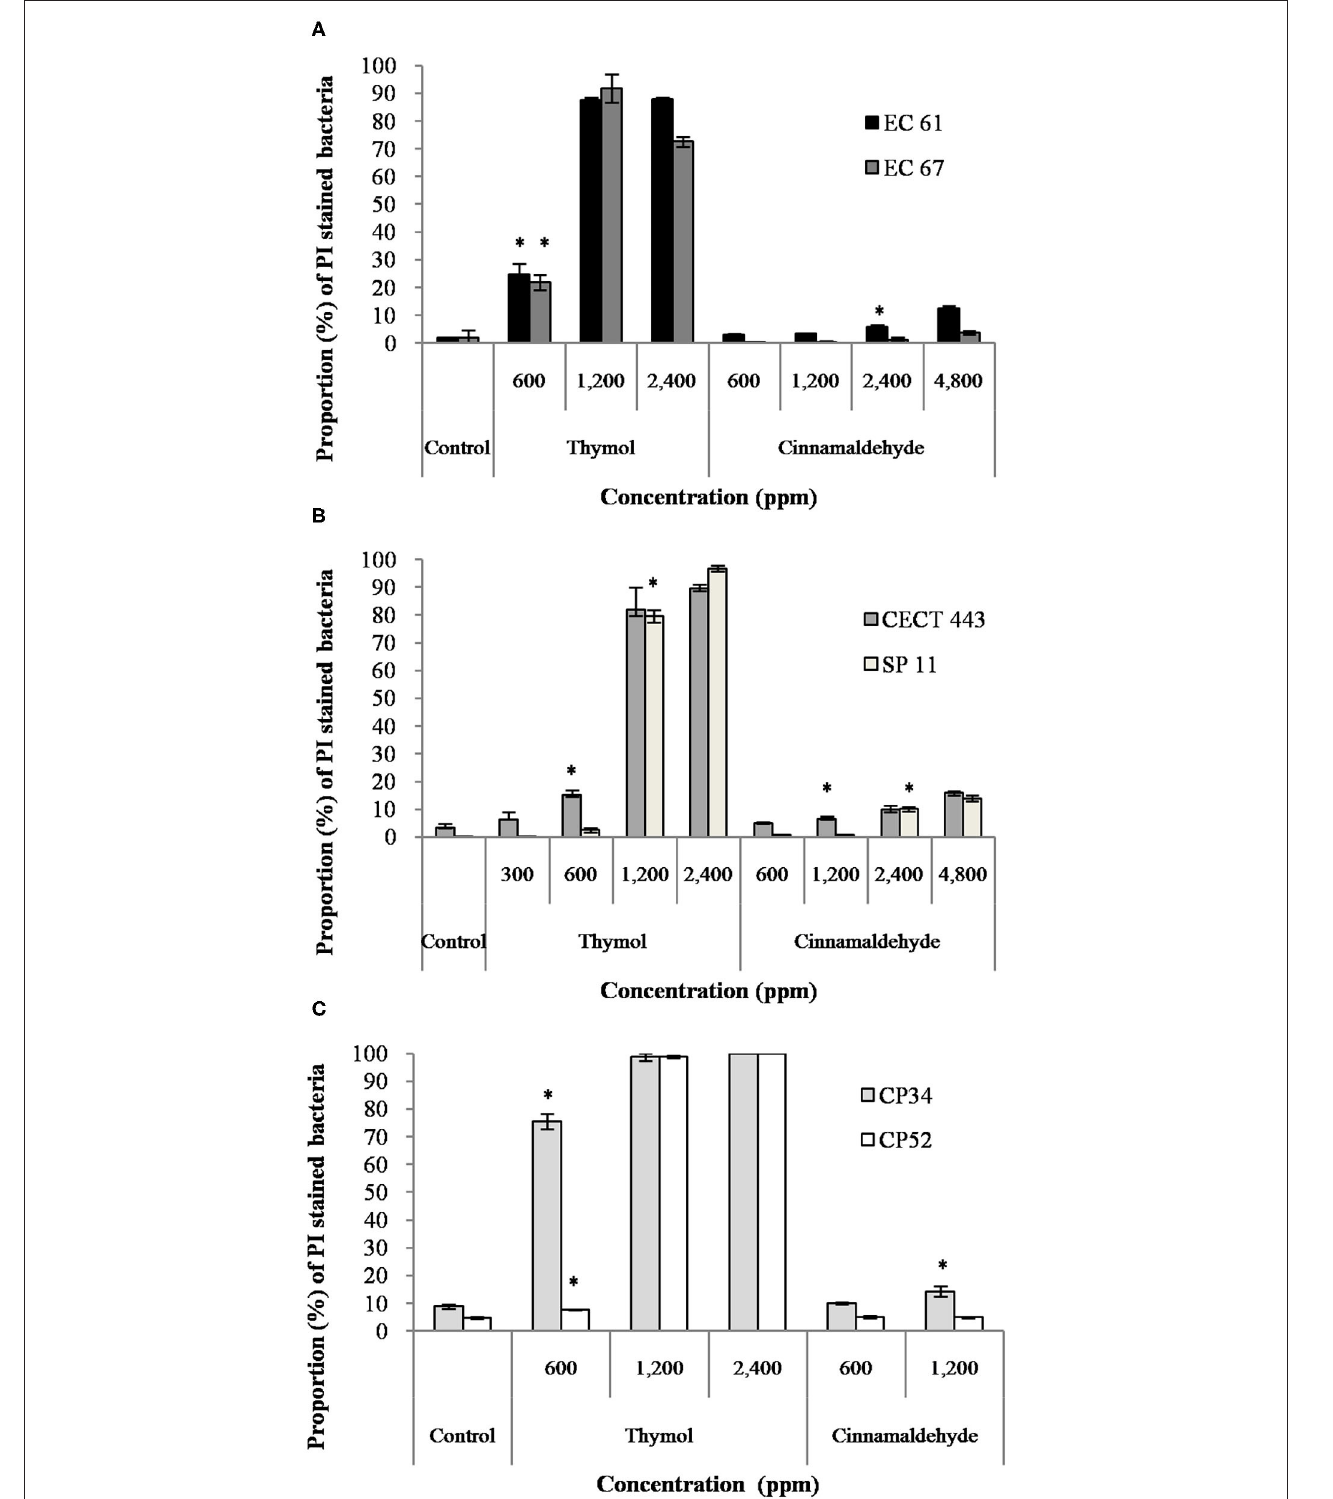
FIGURE 2 | Proportion of propidium iodide (PI) stained bacteria of E. coli (A) , S. Typhimurium (B) , and C. perfringens (C) among controls without products and after the exposure to different concentrations of thymol and cinnamaldehyde for 90min at room temperature. Data are expressed as mean of the three independent replicates ± standard deviations. *Denotes the lowest concentration of product in which PI stained bacteria significantly differed to controls ( p < 0.05).